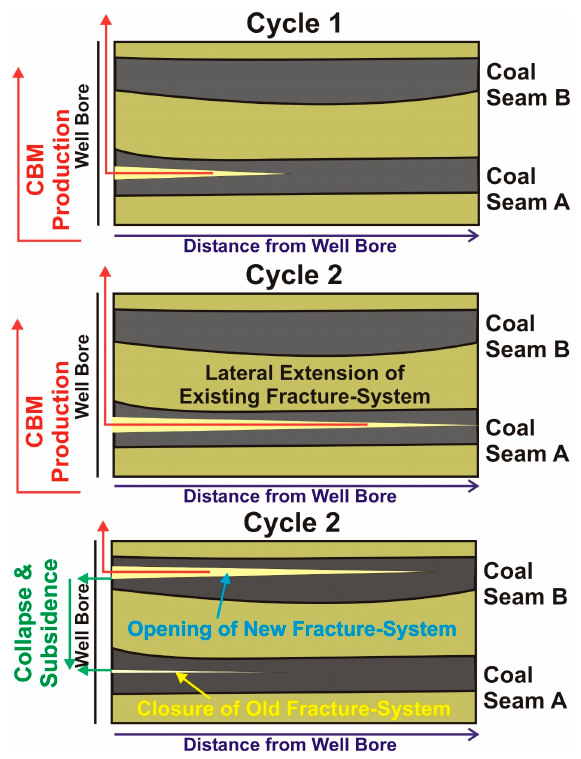
Figure 10. Idealized model showing closing and opening of fracture systems in coal seams and lateral extension of fracture system as a result of the production of CBM from wells of production sample set P3. set